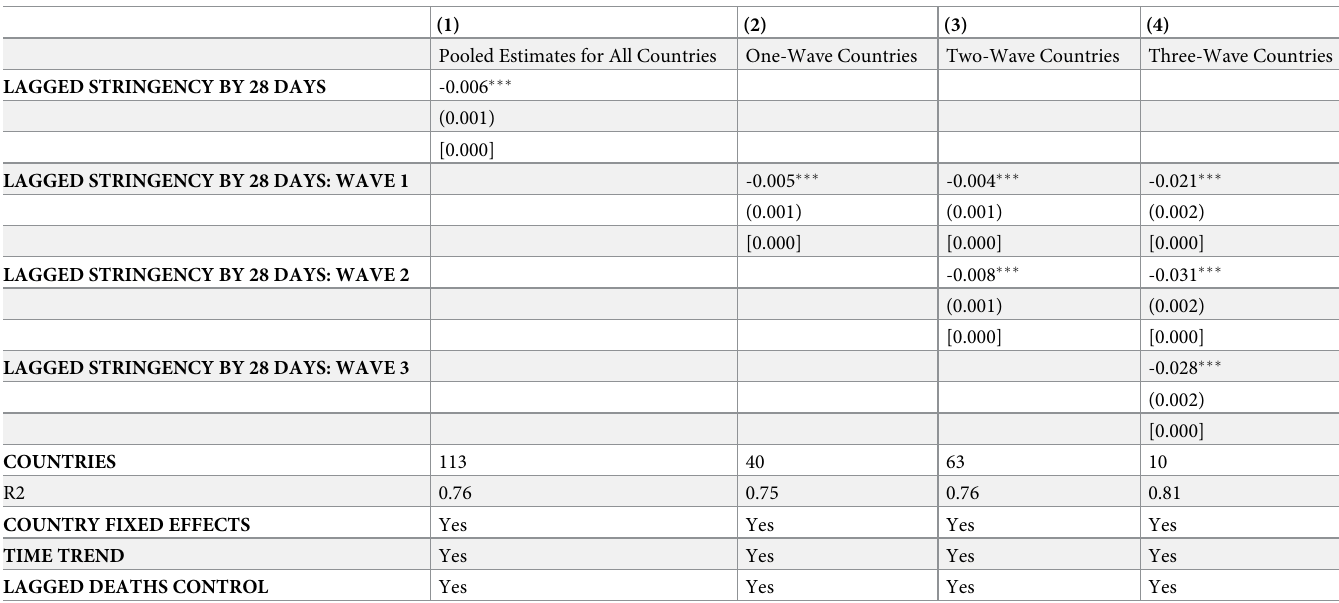
Table 1. Association of government response stringency and deaths by